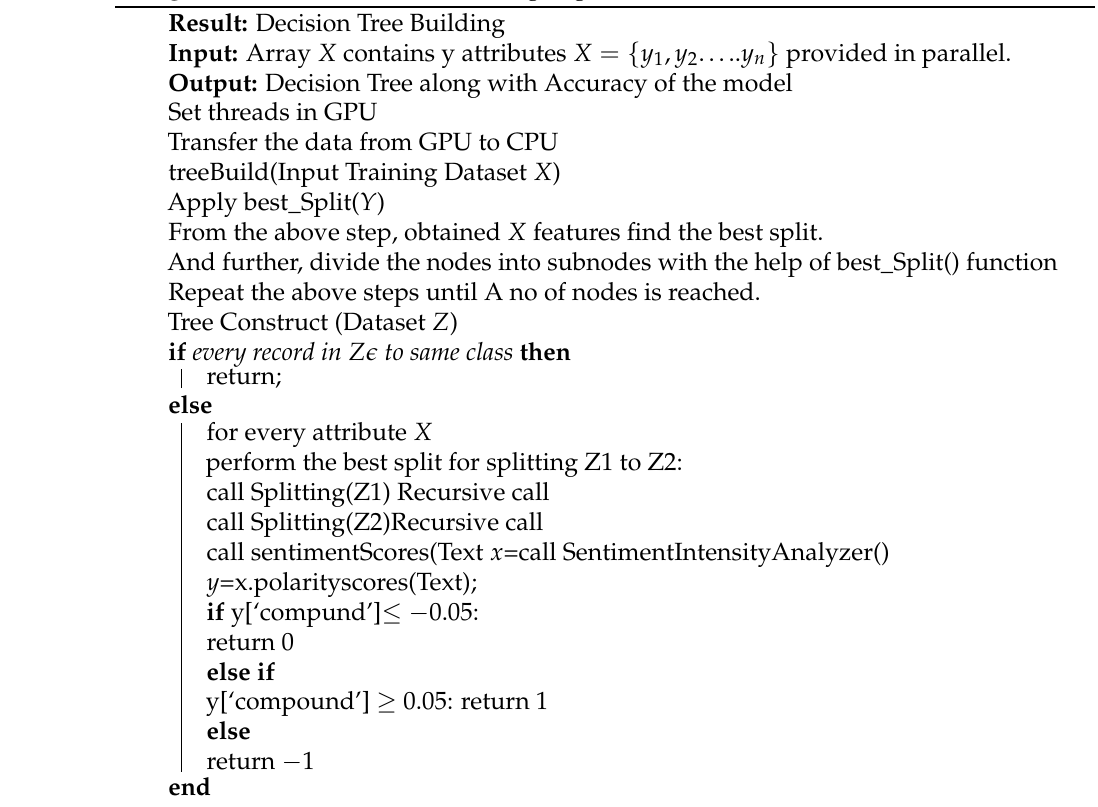
Algorithm 1: Decision Tree Building Algorithm Result: Decision Tree